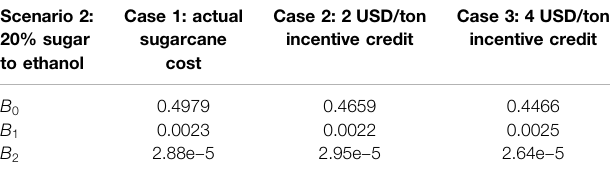
TABLE 4 | Correlation parameters for minimum ethanol selling.